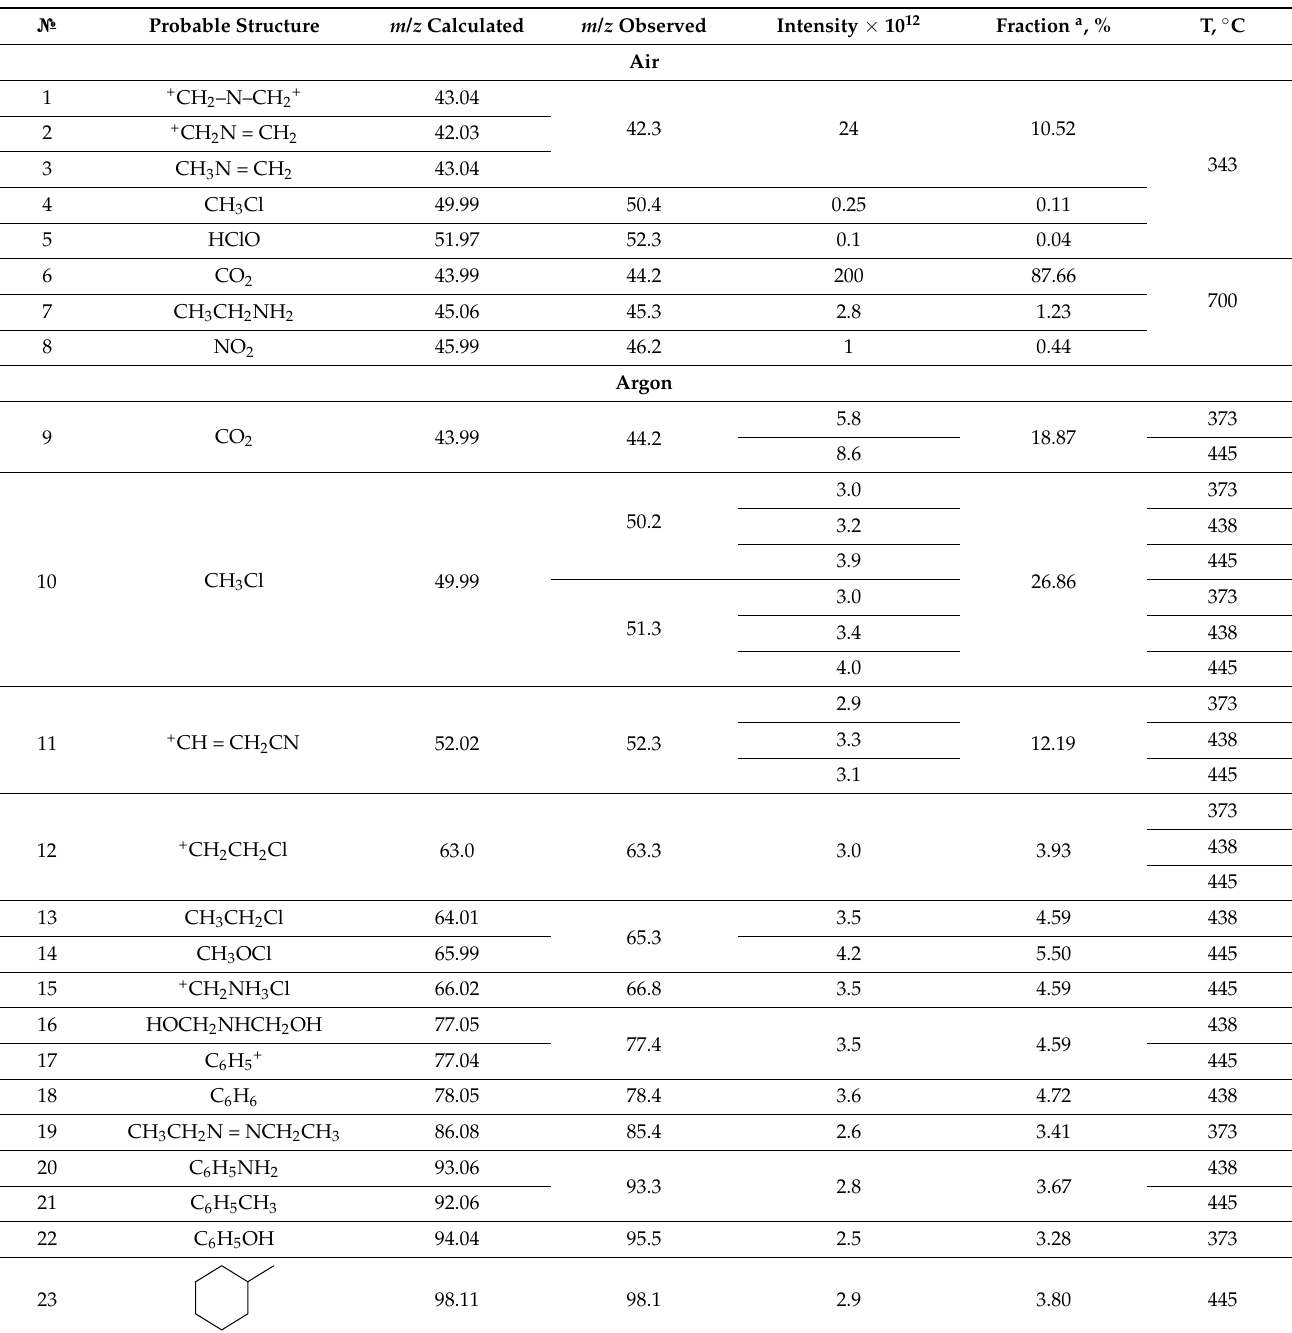
Table 7. The results of TG-MS analysis of volatile products of polyP-q in air and inert atmosphere.